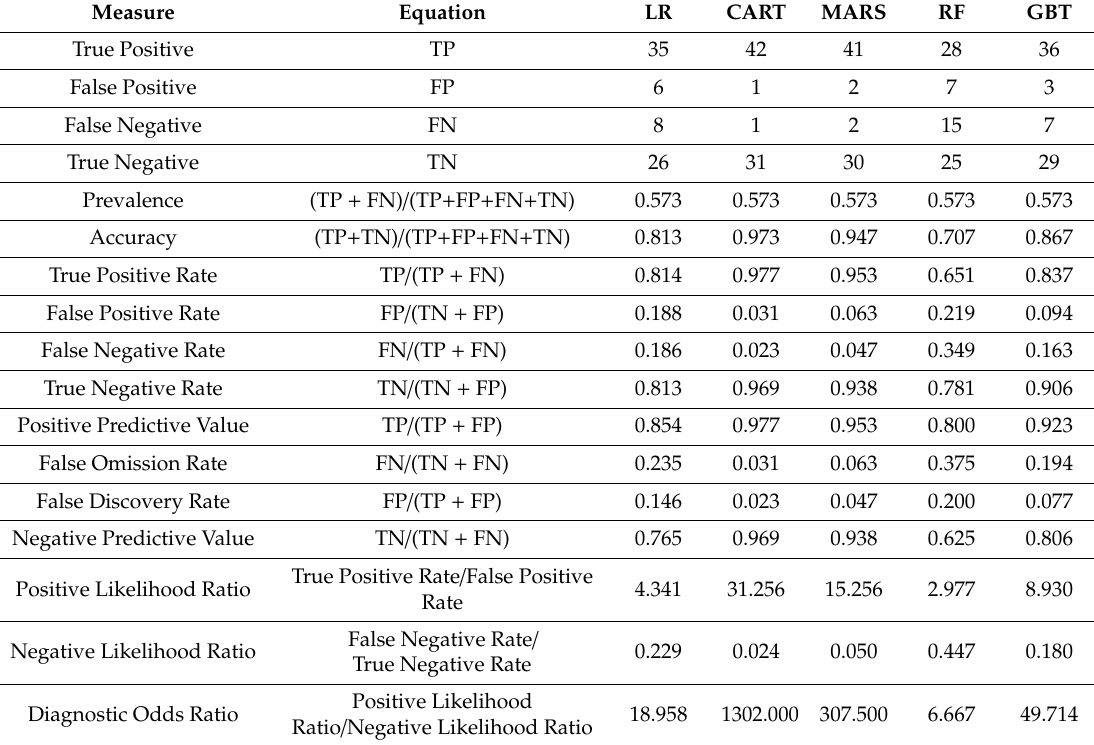
Table 4. Performance Metrics of Tree-Based Models for the Training